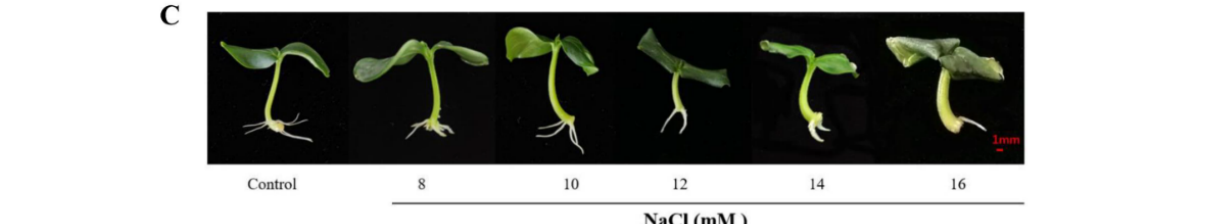
Figure 1. Effects of different concentrations of NaCl on adventitious root development in cucumber explants. The primary roots were removed from hypocotyl of 5-day-old seedlings. Explants were incubated for 5 days with distilled water (the control) and different concentrations of NaCl (0, 8, 10, 12, 14, and 16 mM). The numbers ( A ) and root length ( B ) of adventitious root were expressed as mean ± SE ( n = 3, 10 explants were used per replicate). Values are means of three independent replicates. Photos [overall plant morphology ( C )] of the plants were taken 5 days after treatment.